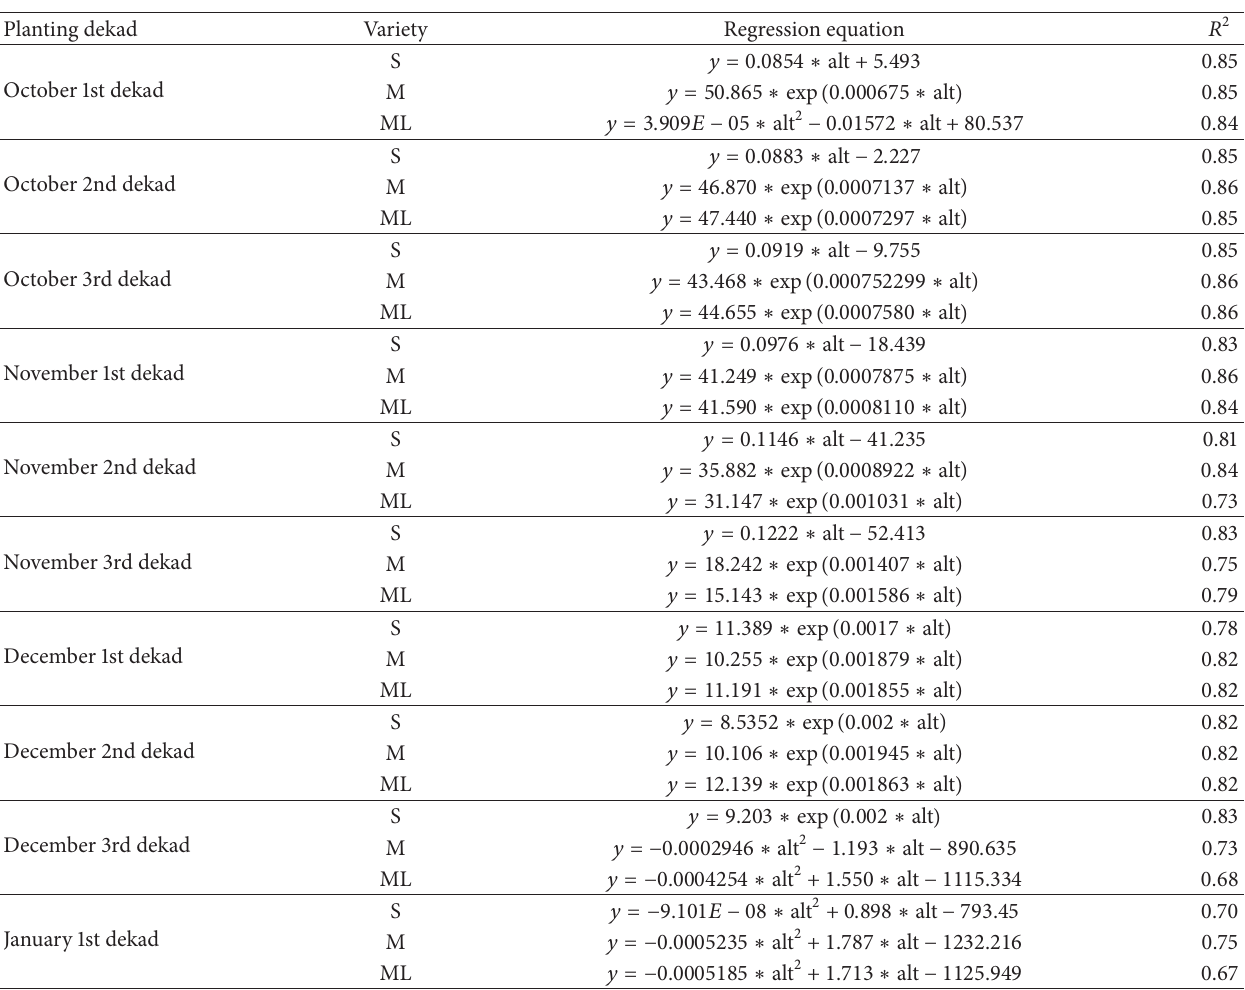
Table 1: Equations and 𝑅 2 values for the regression between 50% nonexceedence probability of growing period against altitude in the Free State for short (S), medium (M), and medium-late (ML) season varieties. Planting